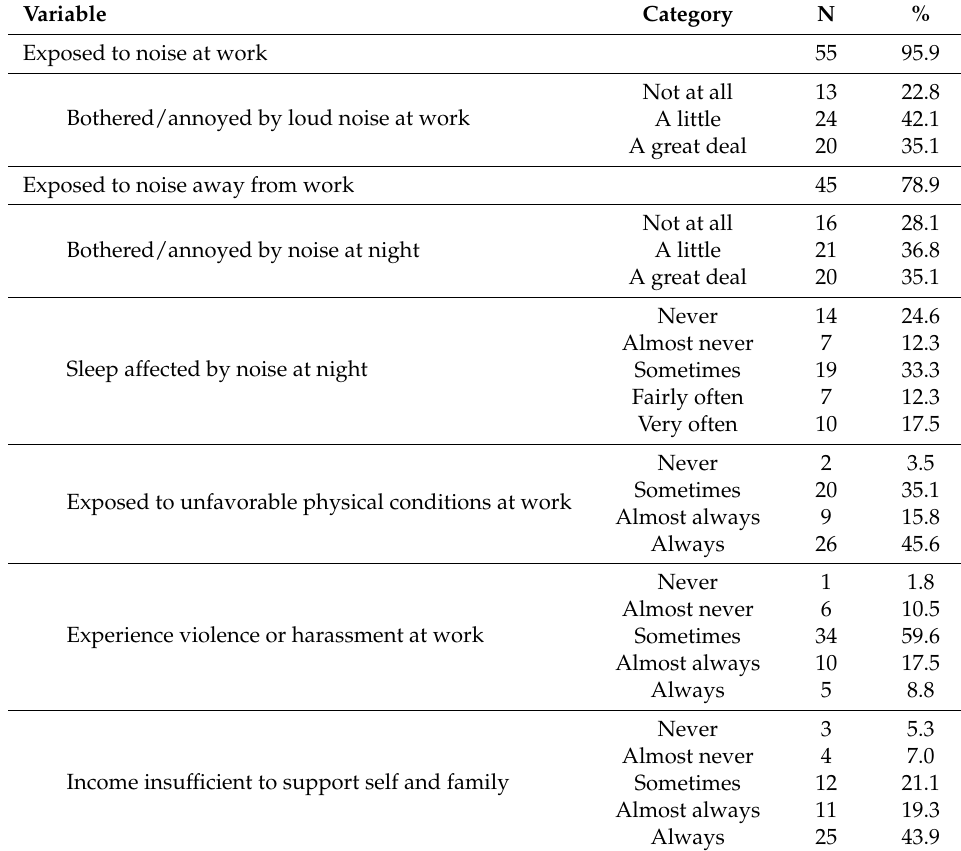
Table 2. Self-reported exposures ( N = 57